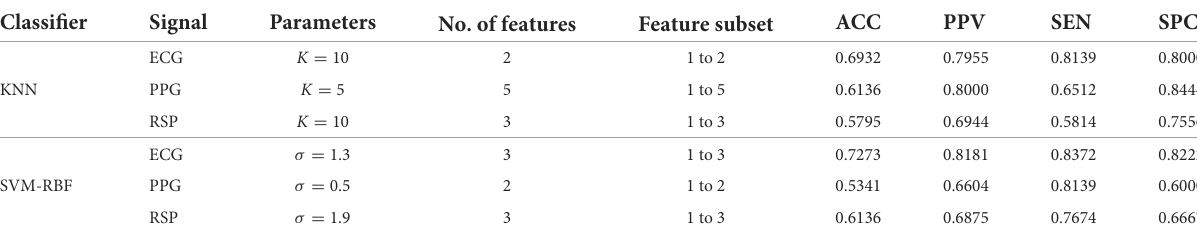
TABLE 5 Top results obtained for MDDSI classification using KNN and SVM-RBF classifiers with single physiological